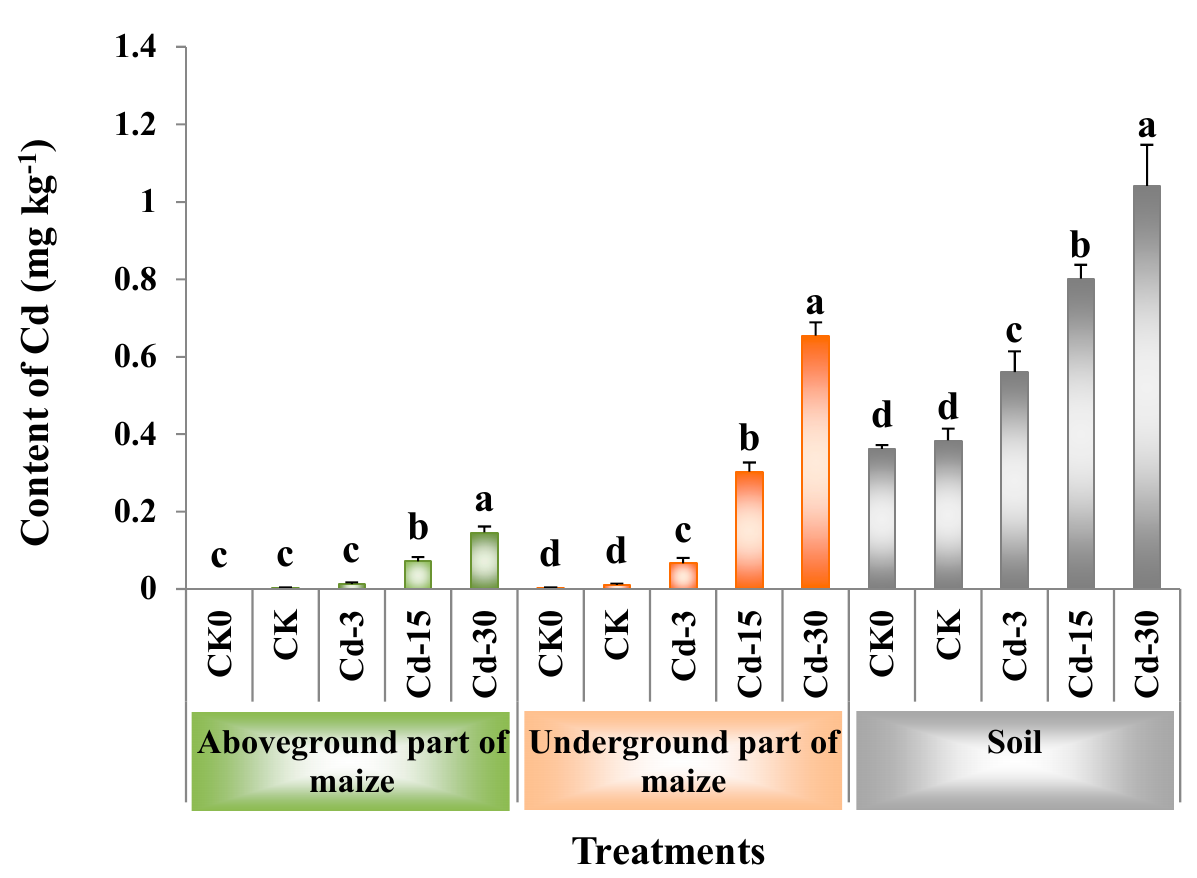
Figure 2. Contents of Cd (mean ± SE, n = 4) in soil, aboveground, and underground parts of maize under different treatments. Different letters denote significant difference at p < 0.05. CK0: Maize planting without any fertilizer application.